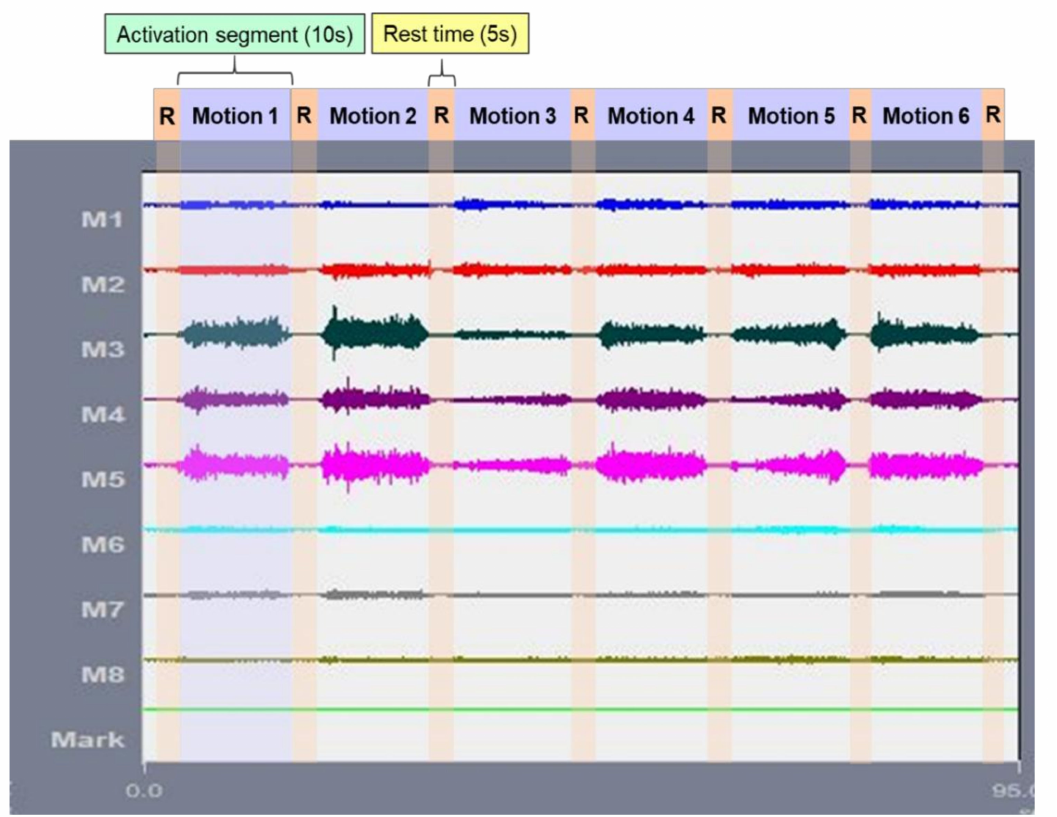
Figure 8. A sample of EMG signals for each